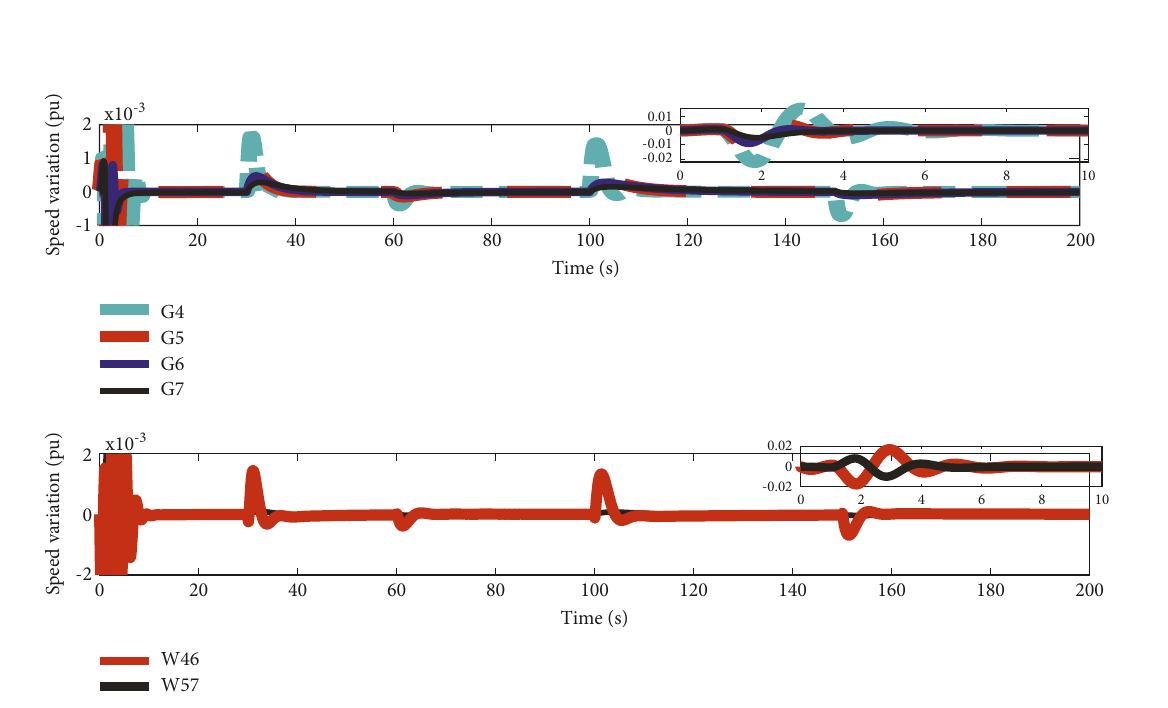
4 , G 5, G 6, and G 7